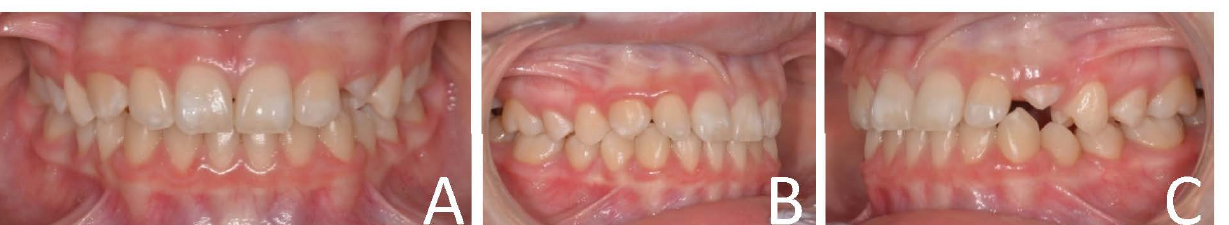
Figure 34. Intraoral photographs of the subject after treatment and a 3-year follow-up period (12-year-old). ( A ) Frontal view; ( B , C ) lateral view.